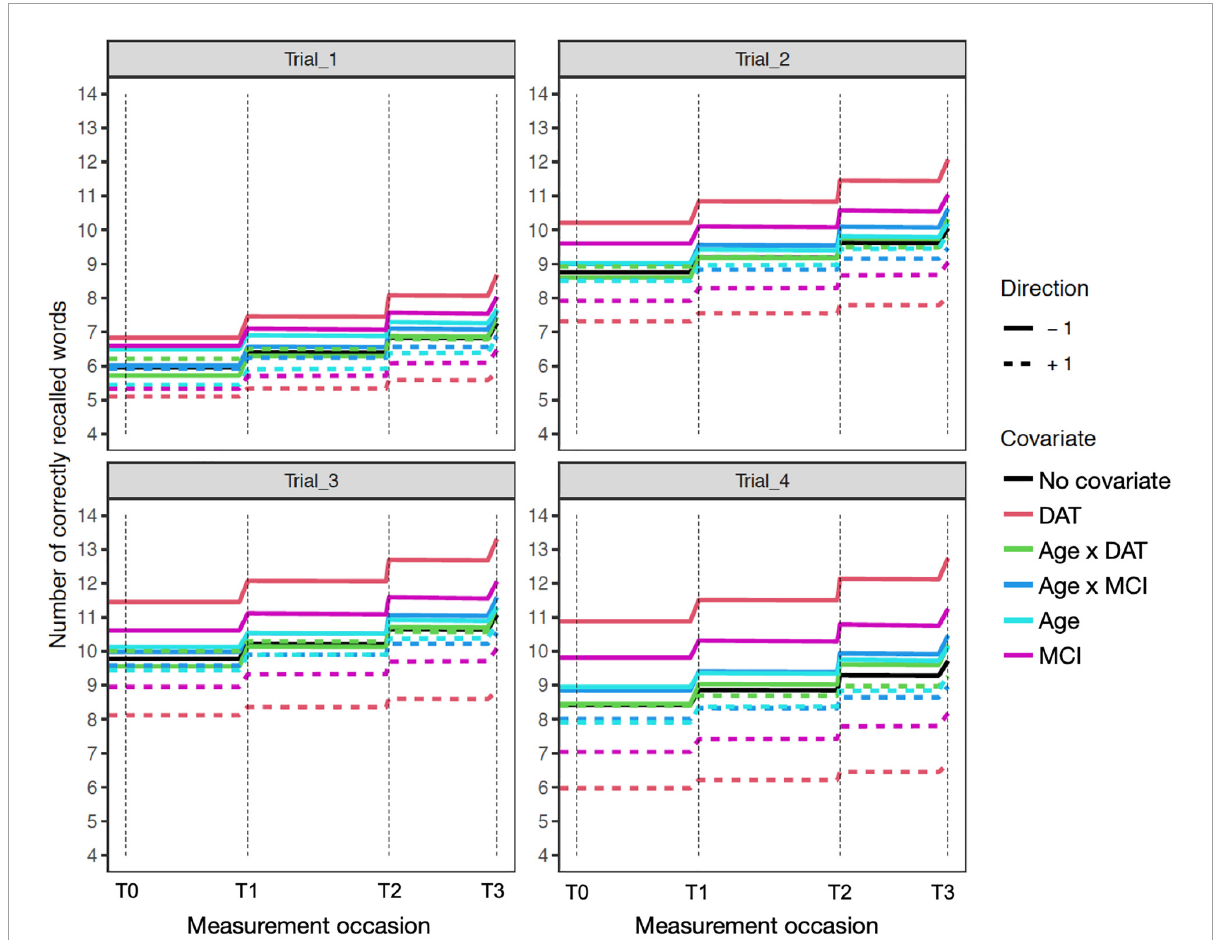
FIGURE3 Age sensitivity model expectation plots for change in recall performance (black line) across four measurement occasions (e.g., T0: baseline, T1: 1 year). The solid and dashed colored lines depict effect modification by time independent predictors: DAT diagnosis (red lines), MCI diagnosis (magenta lines), Age (light blue lines), and interactions of Age × DAT and Age × MCI. For main effects, higher (dashed) and lower (solid) levels of the covariate modifies the level and expected patterns of change. All effects are in reference to 0 values on other covariates. The dashed red line reflects DAT, and the solid red line represents all other participants. Interaction effects only represent the total additive value of the interaction, when holding the main effects at